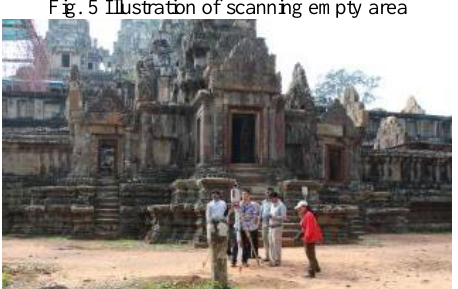
Fig. 5 Illustration of scanning empty area